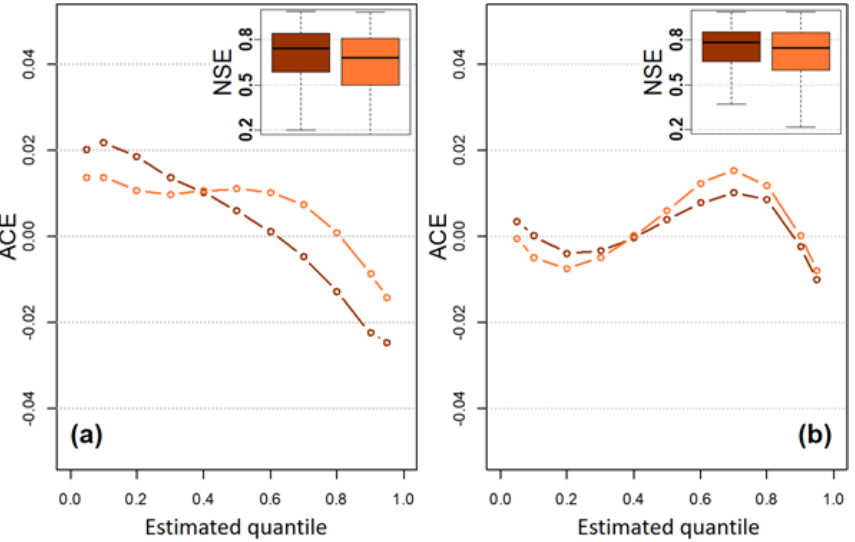
Figure 10. Average coverage error of the Dvine model for two scenarios under (a) the deficit and (b) sufficient cases. In each case, the dark line represents the scenario by the marginal cumulative probabilities using all years and conditional streamflow values constructed from the partial record. On the other hand, the light line illustrates the scenario by the marginal cumulative probabilities estimated by the partial record and conditional streamflow values constructed from the full record. The inset shows the NSE performance of the Dvine model for the two scenarios in each